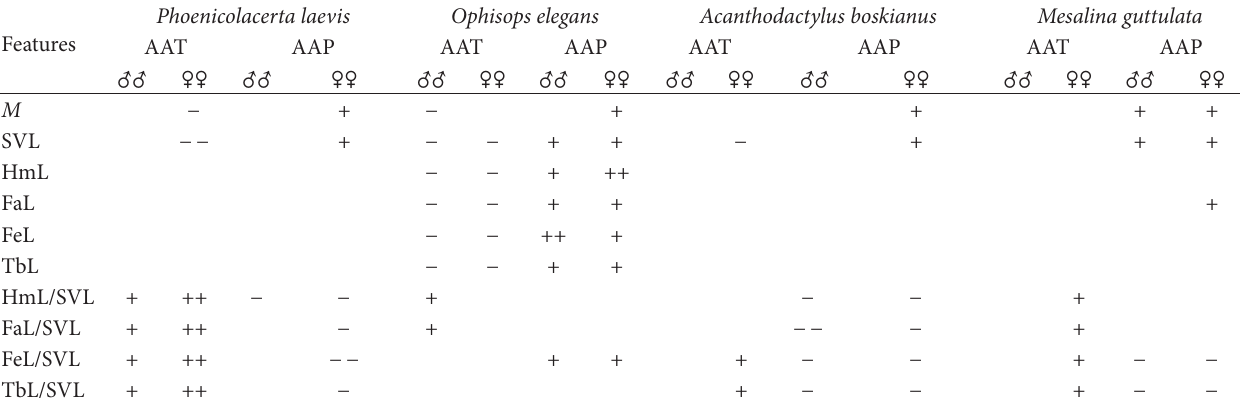
Table 2: Climate-morphology relationship between average annual temperature (AAT)/average annual precipitation (AAP) and body measurements/ratios (regression analysis with temperature and precipitation as the predictors and features as the responses). Positive correlation (+) and negative correlation ( − ); single sign: significant difference ( 𝑃 < 0.05) and double sign: highly significant difference ( 𝑃 < 0.0001).